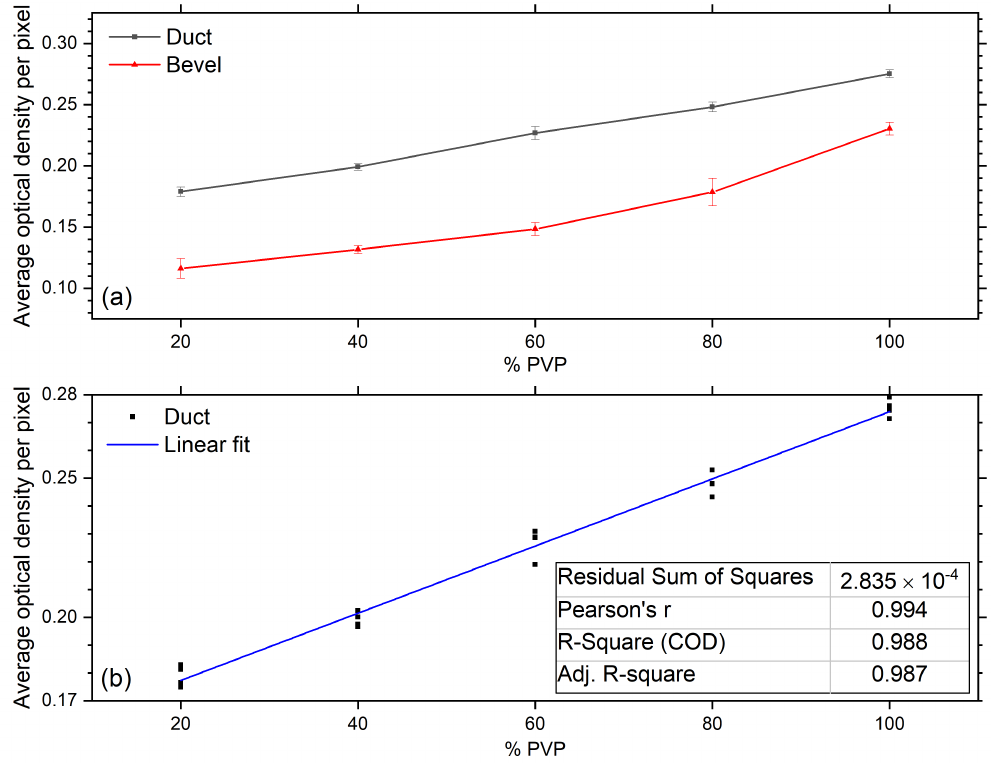
Figure 8. ( a ) Average optical density per pixel, for duct and bevel components, of samples coated with diluted PVP solutions. ( b ) Linear fit to average optical density per pixel data of duct. The fit parameters are given in the inserted table and demonstrate water dilution could be monitored using IR transmission